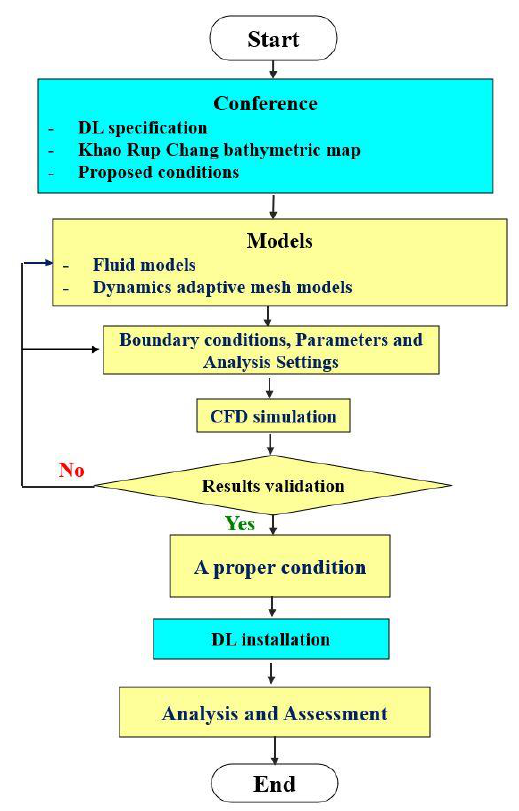
Figure 3. A flowchart of research methodology.